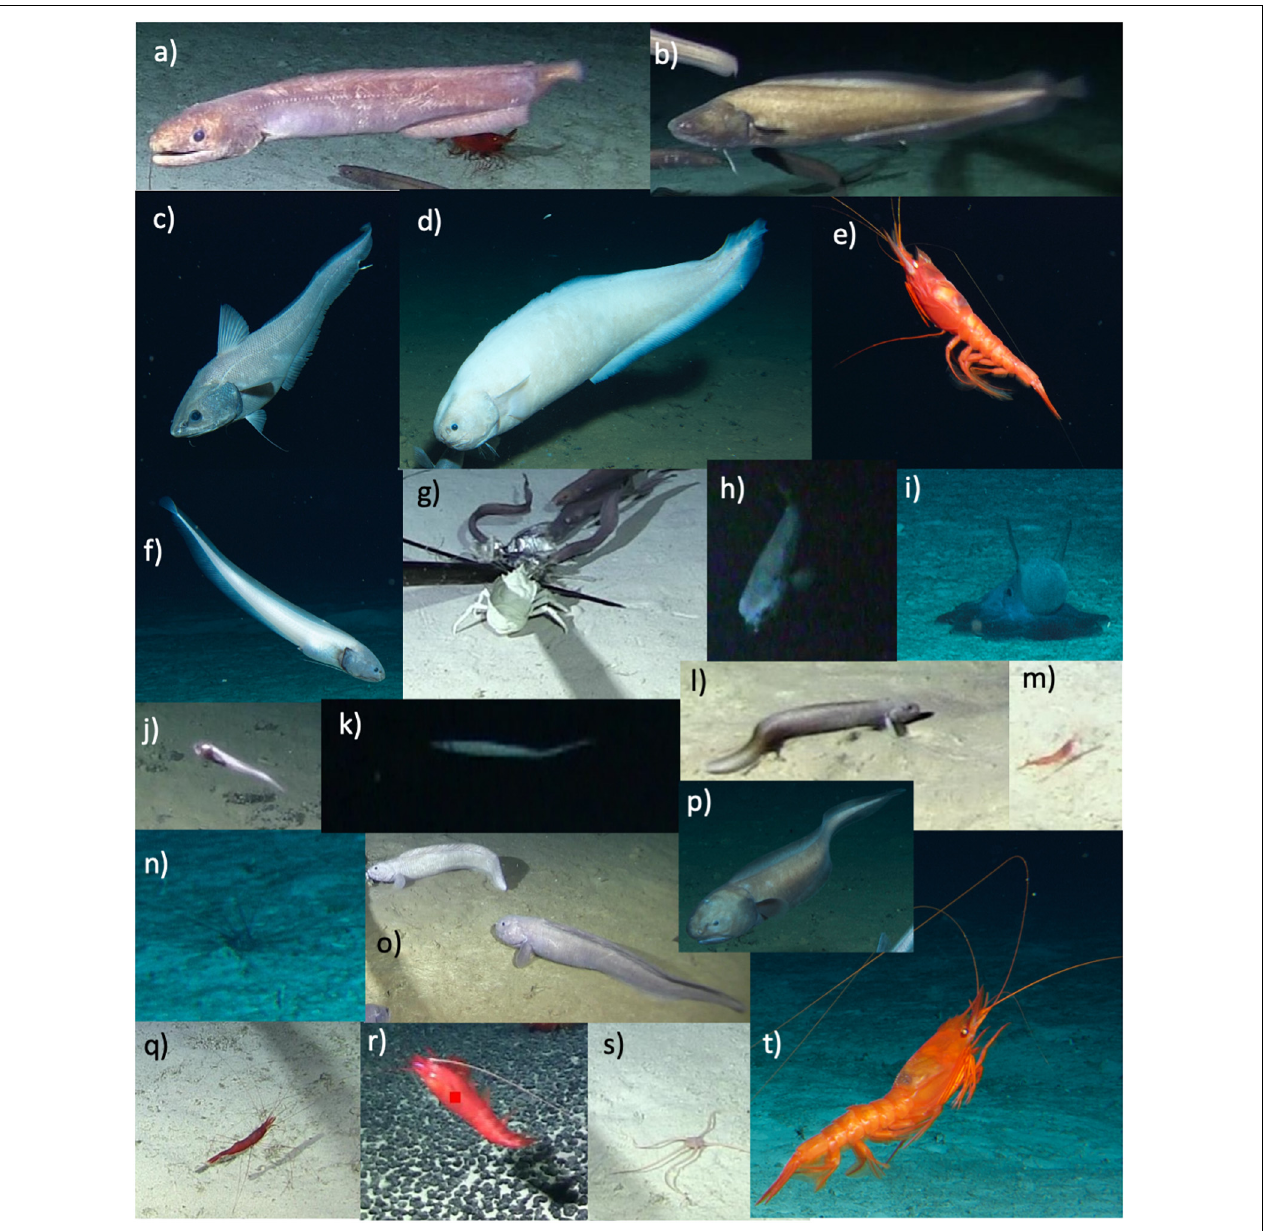
FIGURE 3 | Twentymorphospecies seen across the seventeen successful baited camera deployments. (a) Ilyophis arx (b) Bassogigas walkeri (c) Coryphaenoides armatus/yaquinae complex (d) Barathrites iris (e) Benthiscymus sp. (f) Bassozetus sp. B (g) Munidopsis sp. (h) Asquamiceps sp. (i) Grimpoteuthis sp. (j) Bassozetus juvenile sp. (k) Halosaur (l) Zoarcid sp. 2 (m) Hymenopenaeus nereus (n) Echinoid (o) Pachycara nazca (p) Bassozetus nasus (q) Nematocarcinus sp. (r) Acanthephyra sp. (s) Ophiosphalma c.f. glabrum (t) Cerataspis monstrosus .